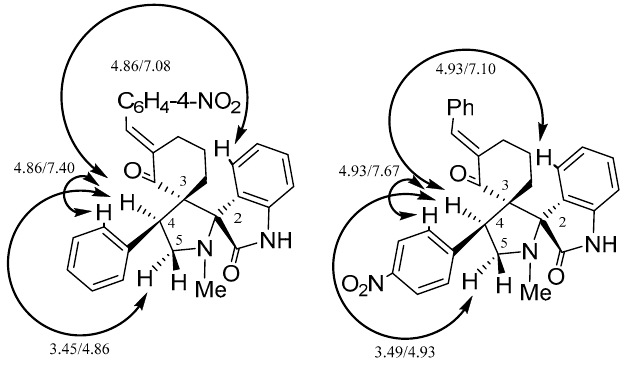
Figure 3. The key NOE contacts for 2 and 3c .